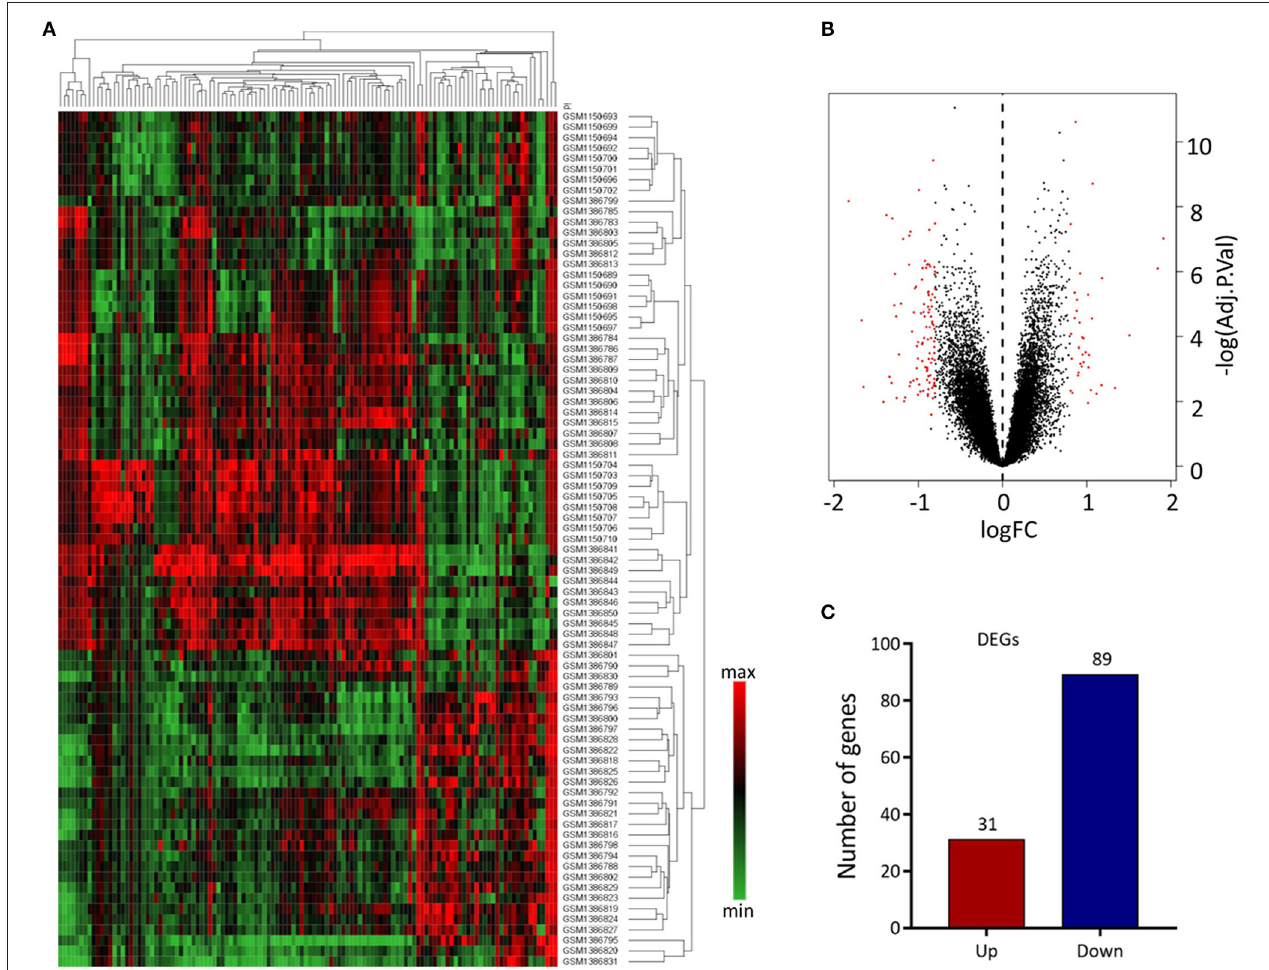
FIGURE 1 | Differential expressed gene (DEG) analysis. (A) Heatmap of 120 DEGs. The diagram presents the result of a two-way hierarchical clustering of all the DEGs and samples. Each row in the heatmap represents a sample, and each column represents a gene. The color scale at the right of the heatmap represents the raw Z-score ranging from green (low expression) to red (high expression). (B) Volcano map of DEGS. Magenta dots represent genes with |logFC| > 0.8 and adj.Pval < 0.05. The red nodes on the left represent downregulated DEGs and on the right represent upregulated DEGs; the black nodes represent genes with p -value > 0.05. (C) The number of the downregulated and upregulated